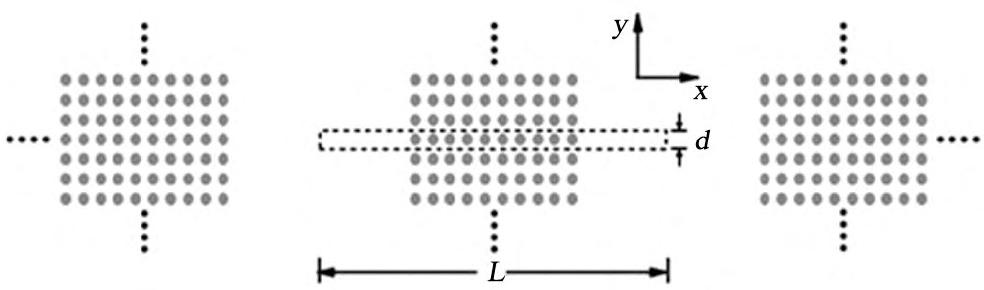
Figure 23. Supercell for calculations of interface modes [78].